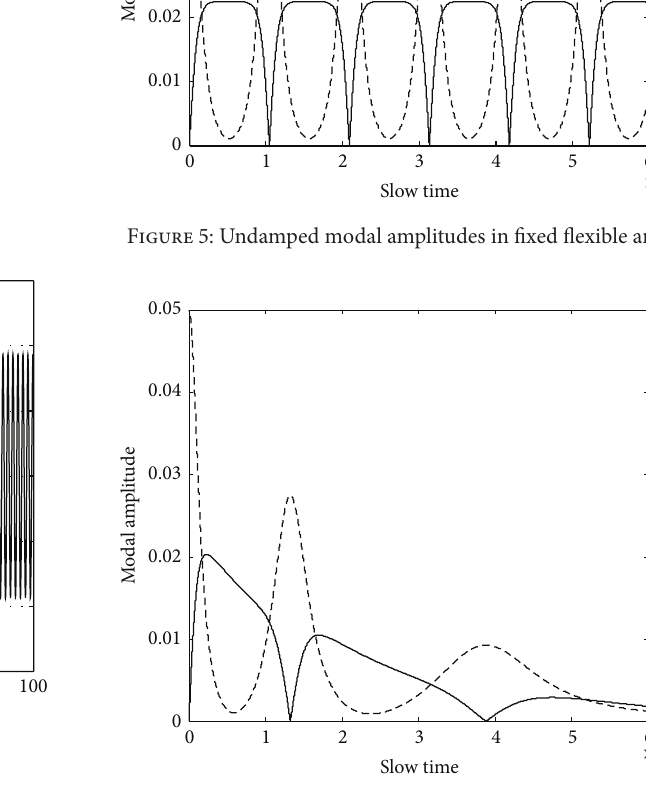
Figure 4: Response of the uncontrolled fixed flexible arm in ADAMS.